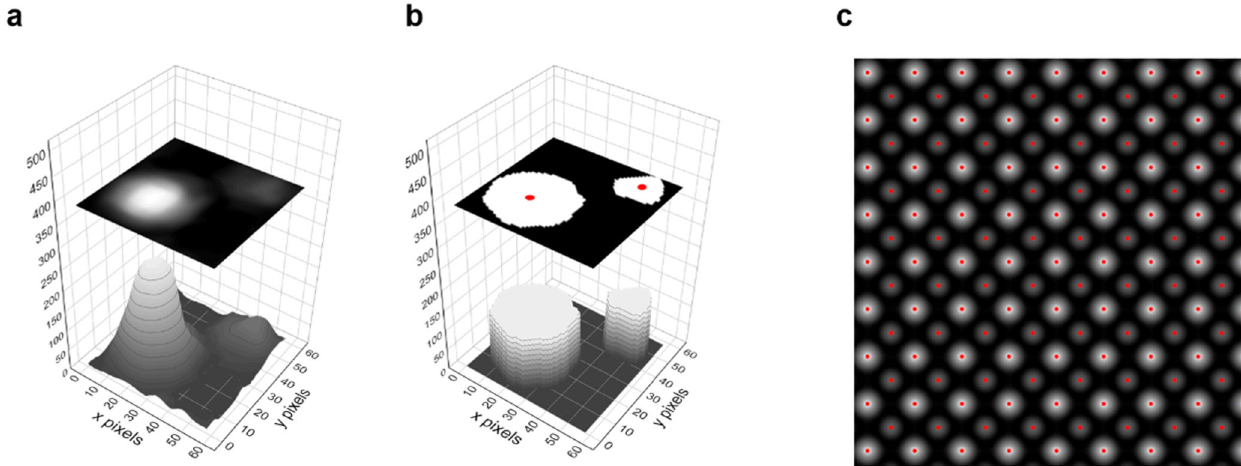
Fig. 3 Graphical representation of segmentation process. a Patched image and corresponding intensity 3D map of the simulated STEM image. b Segmented STEM image from K -means clustering. c Entire segmentation result and extracted atomic coordinates of STEM image. The red dots represent the position of each atomic column.